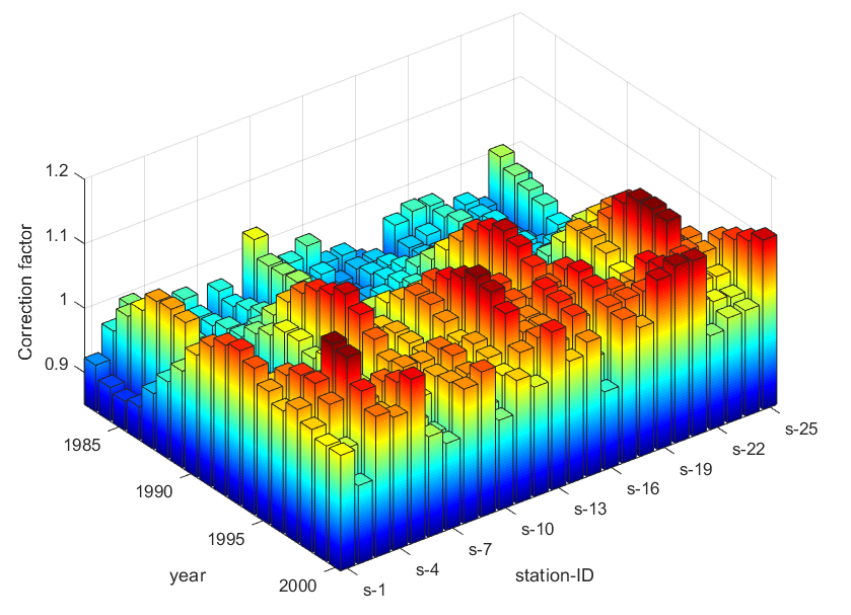
Figure 13. Matrix of correction coefficients for the conversion of the third subcycle (6 years) to the first major cycle (23